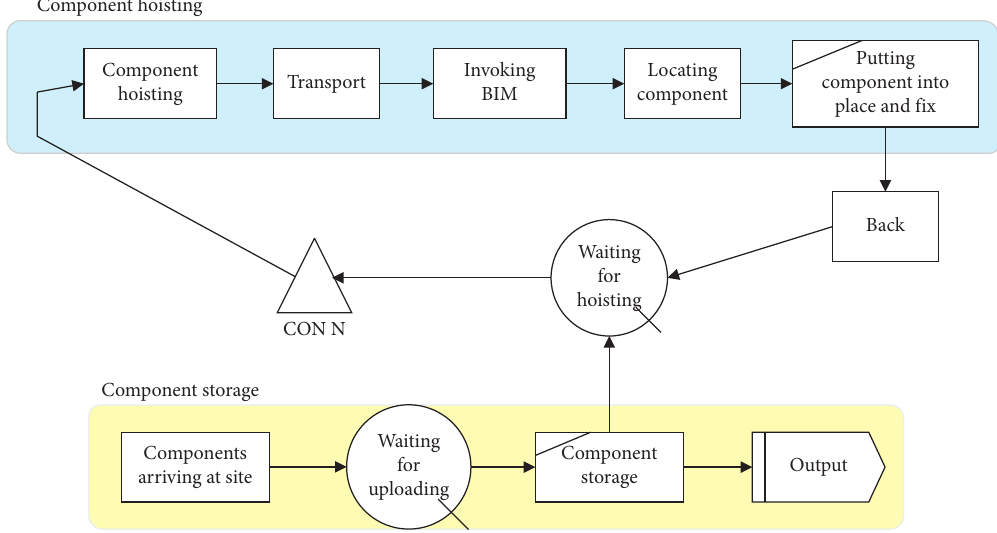
Figure 6: CYCLONE simulation model for component storing and hoisting.